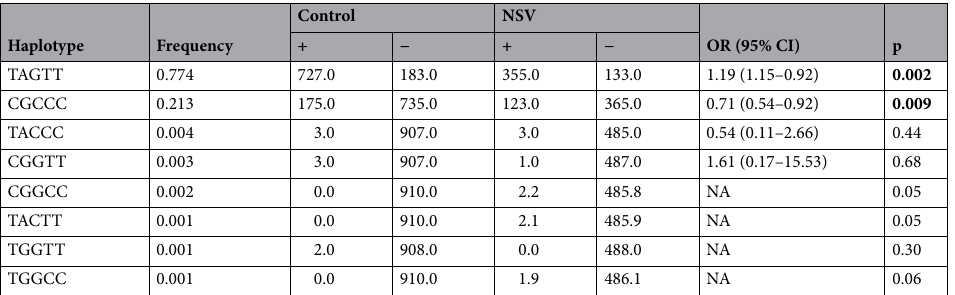
Table 3. Haplotype analysis of GZMB SNPs in the control and the NSV groups. Haplotype with a frequency of more than 0.1 is shown. The haplotypes consist of rs2236337, rs2236338, rs11539752, rs10909625, and